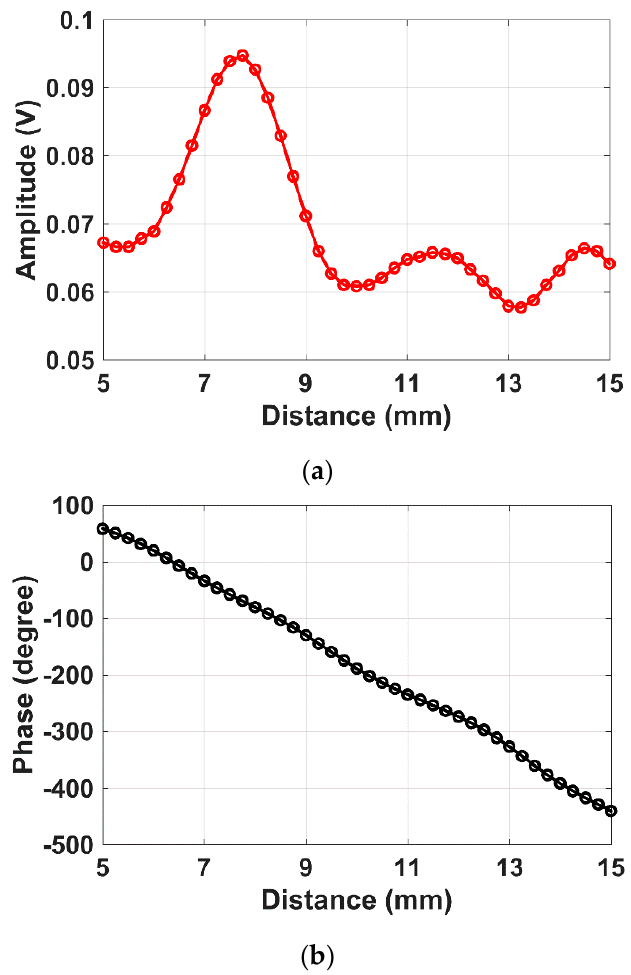
Figure 10. Amplitude and phase of the signal returned from the phantom: ( a ) amplitude; ( b ) phase.